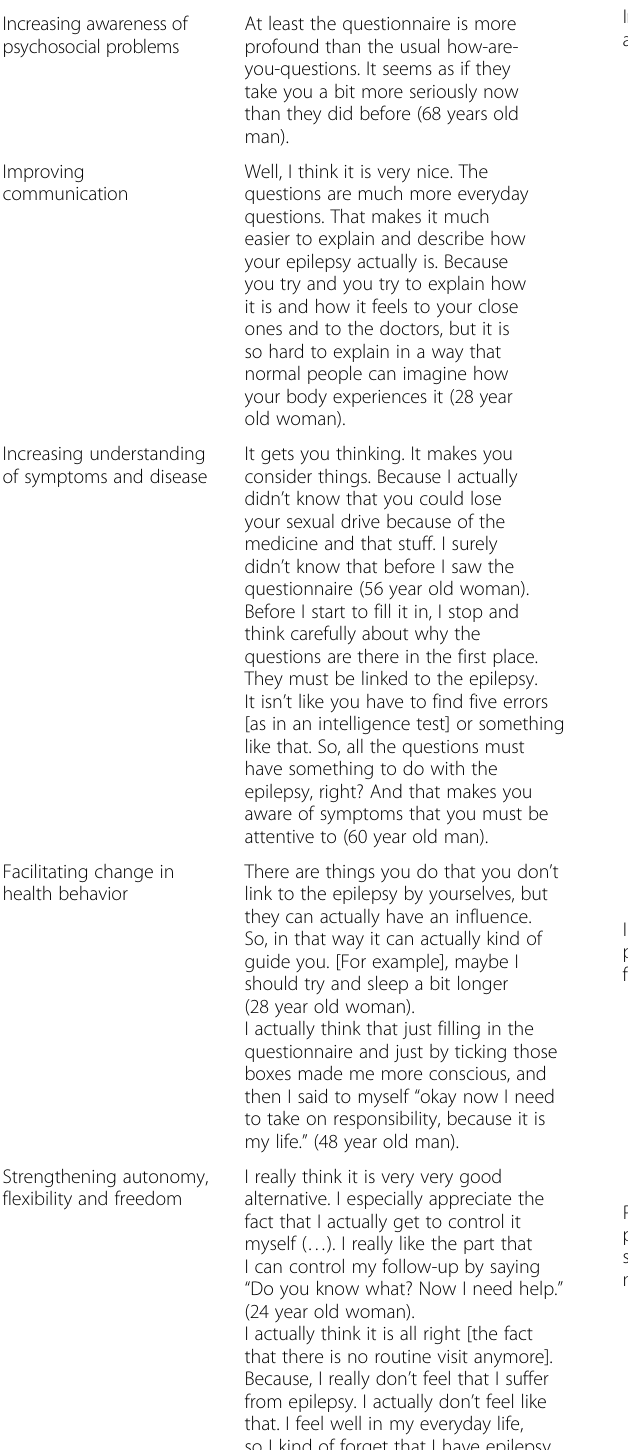
Table 2 Examples of participants ’ quotes Supporting mechanisms